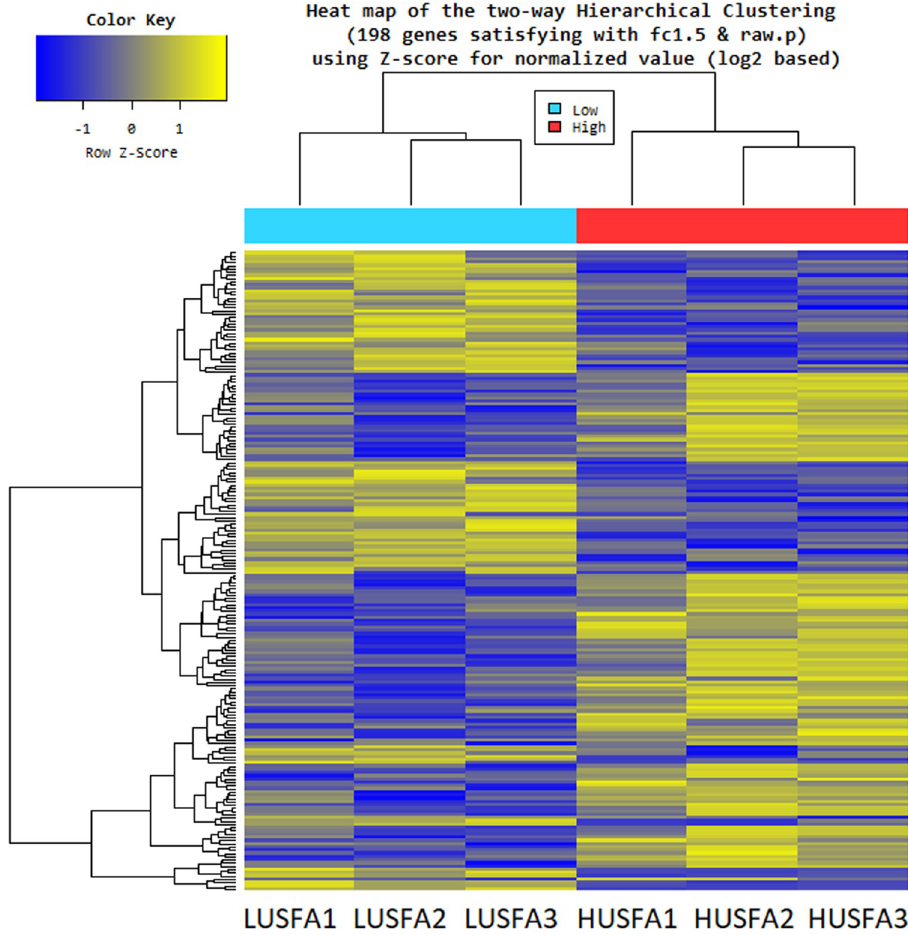
Fig 2. Heatmap showing differentially expressed genes in liver